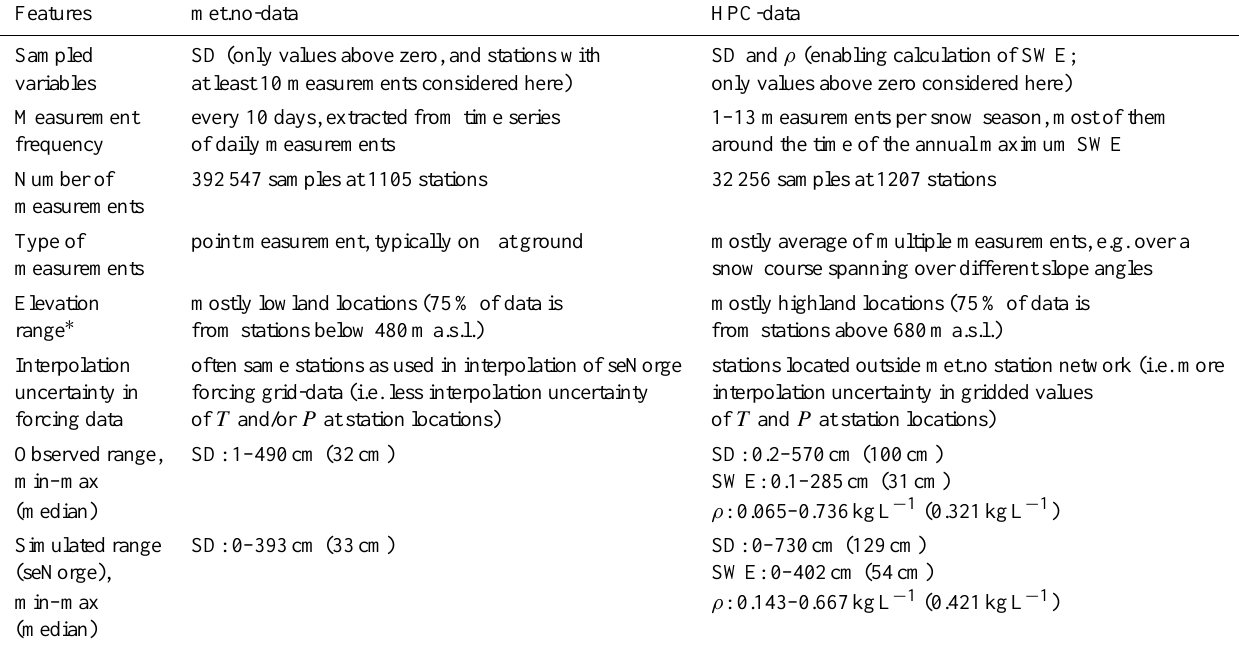
Table 2. Features of the two snow data sets used in the seNorge model evaluation (data since 1 September 1957 is considered). SD, SWE and ρ denote snow depth, snow water equivalent and bulk density, respectively, and “ma.s.l.” elevation (meters above sea